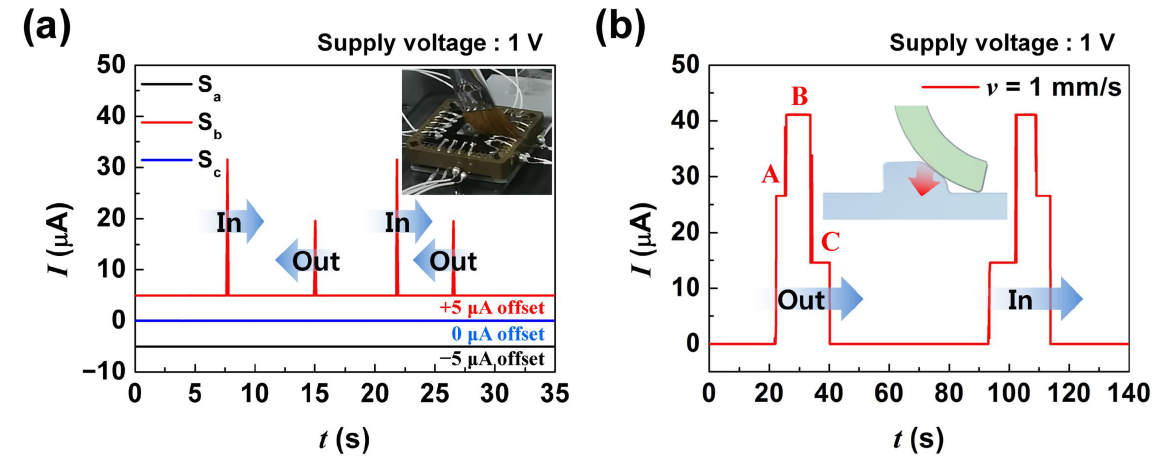
Figure 5. The shear-dependent output characteristics of the shear sensor units: ( a ) the measurement outputs of shear sensor units obtained from brush strokes shown in the inset; ( b ) the measurement output of shear sensor units obtained from PET strip scanning with vertical